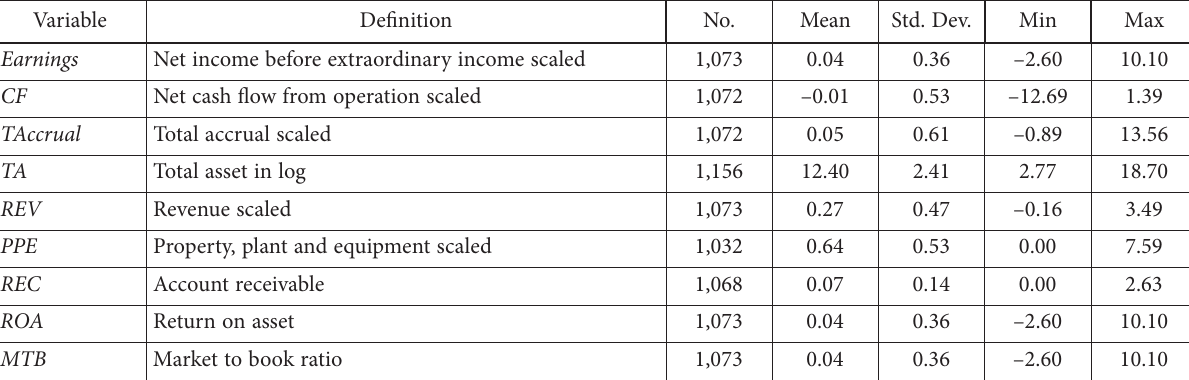
Table 2. Summary of variables for EM measurement